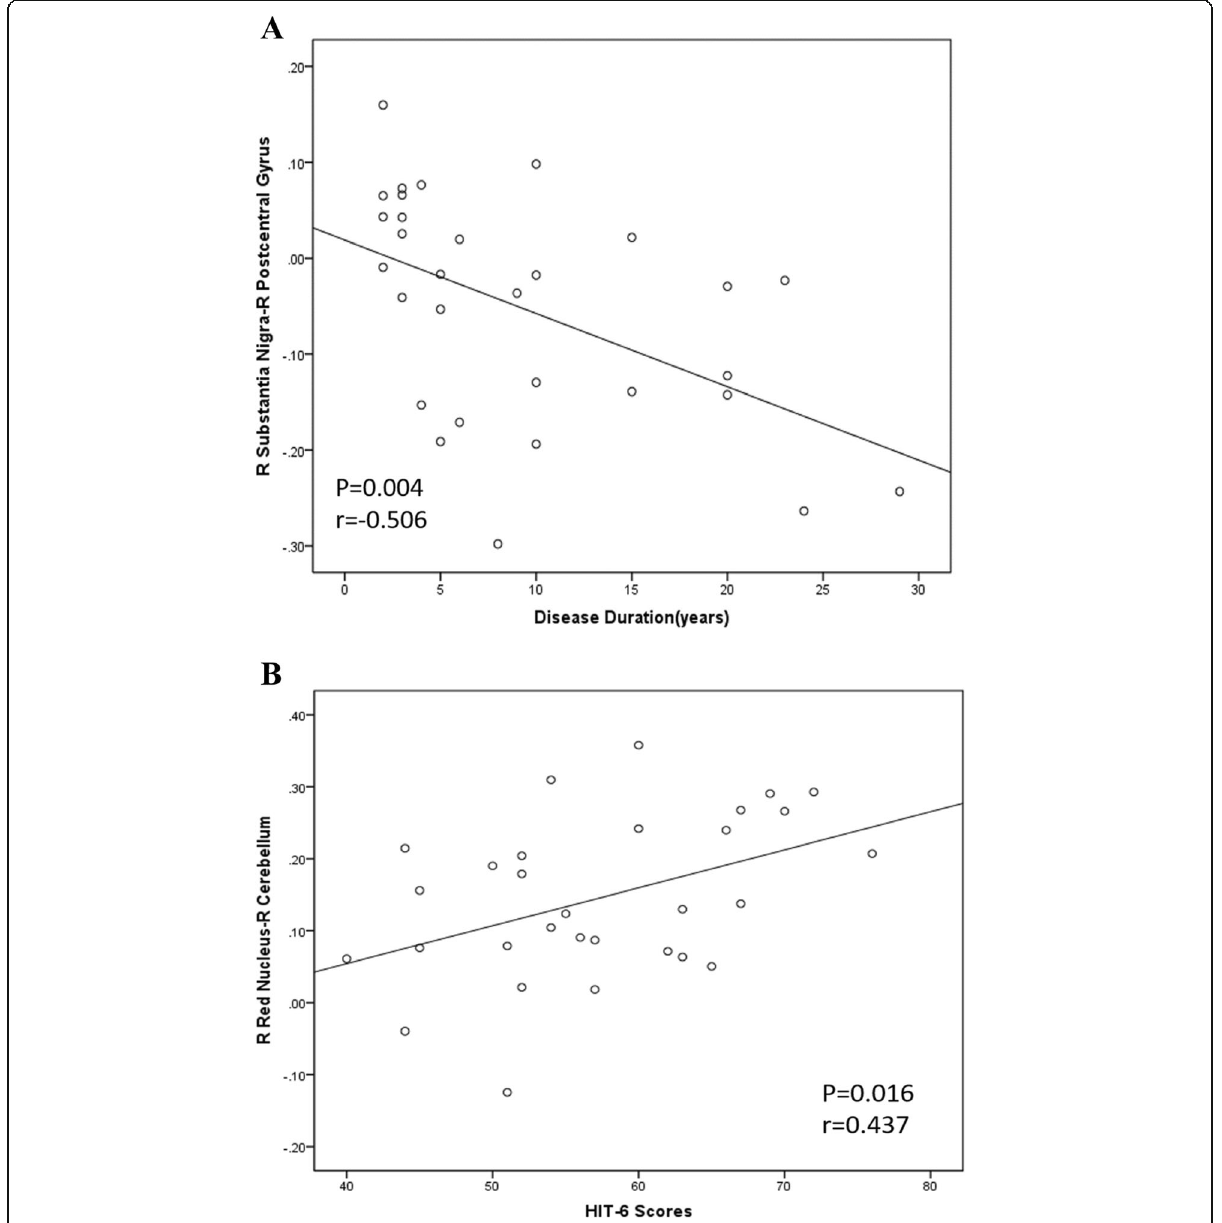
Fig. 3 a 3BSignificant correlations between the brainstem structures ’ functional connectivity and the characteristics of the patients with migraine without aura. Correlations between the functional connectivity of the right substantia nigra-right postcentral gyrus and disease duration ( a ). Correlations between the functional connectivity of the right red nucleus-right cerebellum and the Headache Impact Test-6 scores ( b